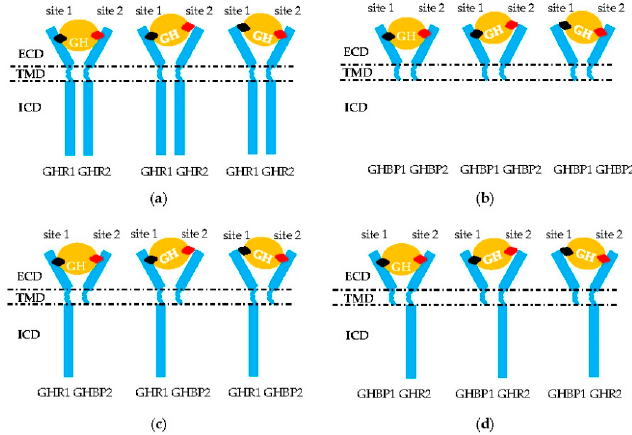
Figure 2. Aberrant signal transduction of GH into the intracellular domain (ICD) of GHR. ( a , b ) Homodimerization of two GHR or GHBP molecules. ( c , d ) Heterodimerization of one GHR and one GHBP molecule or/and GH failing to combine in the GHR – GHBP dimer. Only GH (orange circle) site 1 (black rhombus) or 2 (red rhombus) bind successfully to one molecule in these two homodimers that leads to a failure in the formation of the GH–GHR 2 complex. ECD: extracellular domain; TMD: transmembrane domain; ICD: intracellular domain of GHR.